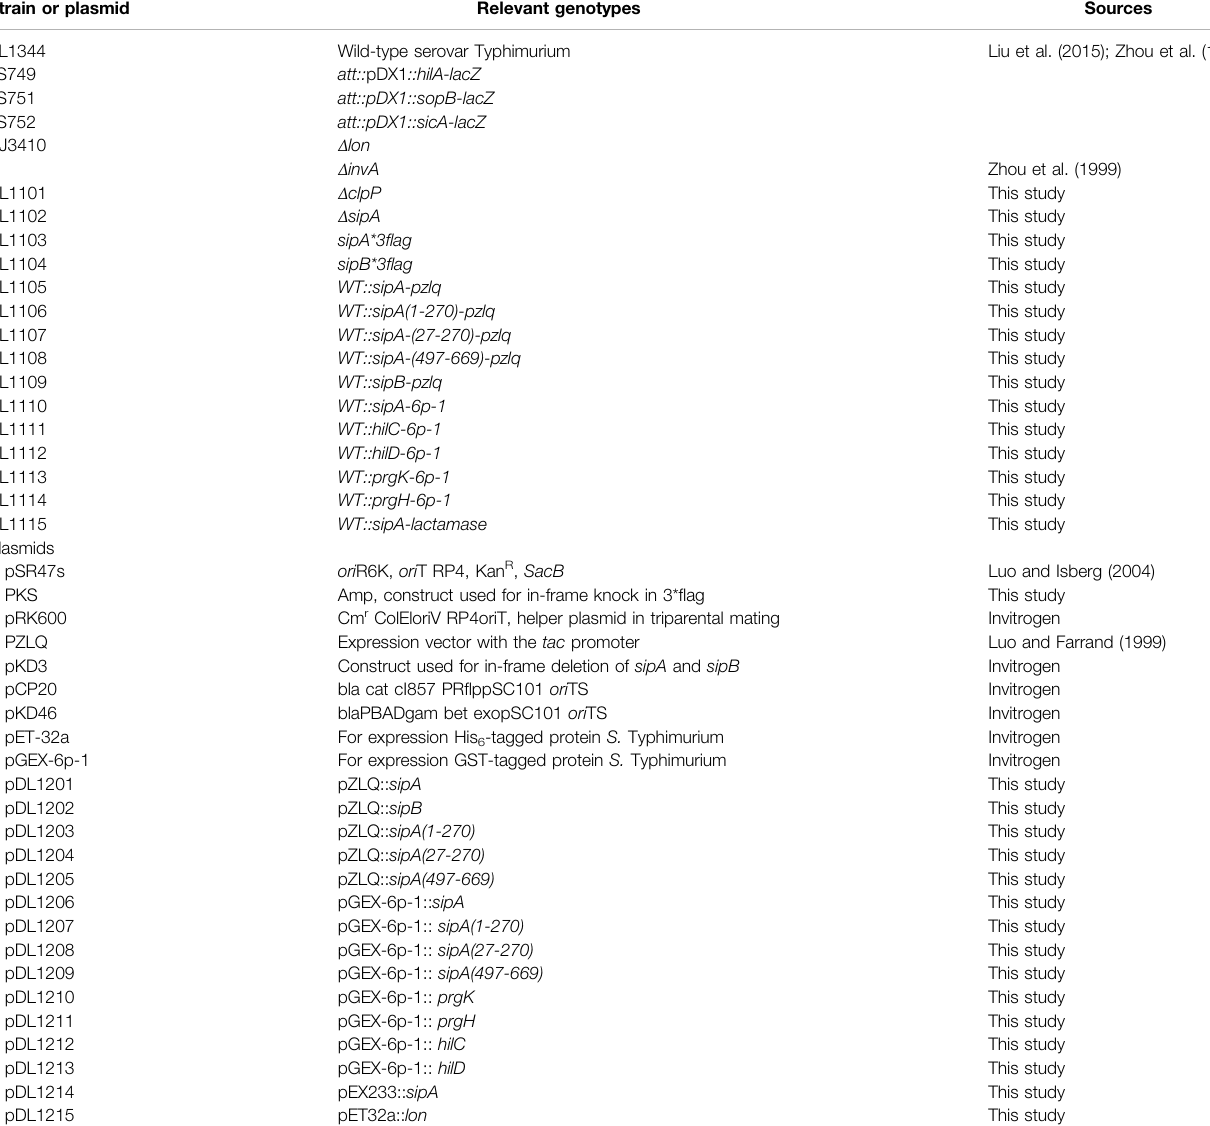
TABLE 1 | Strain or plasmids used in this